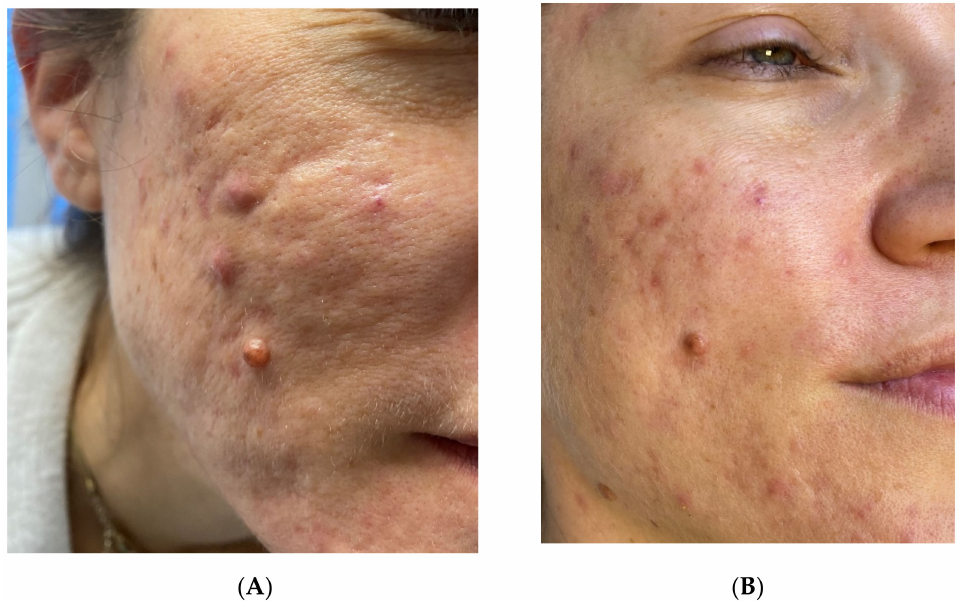
Figure 1. ( A ) Post acne atrophic scar. ( B ) After four sessions performed with LWP-RF device at 0,6watt energy and 3Hz frequency, with detached spots of sublimation performed on the edges around the scars, leaving columns of intact epidermis and sparing the central atrophic part, both to break down the edges and to stimulate the rise of the central skin